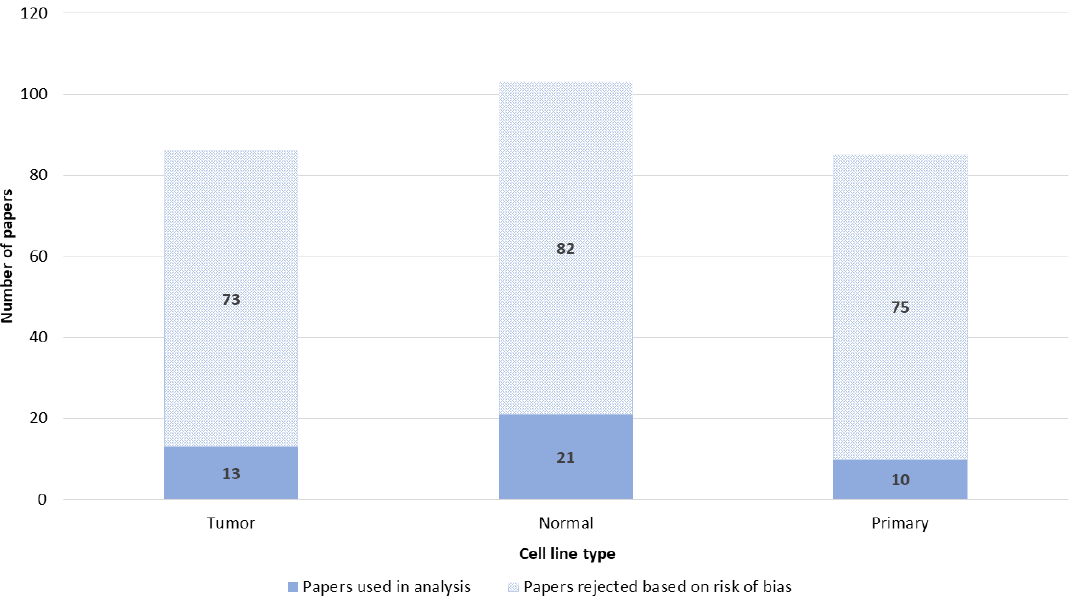
Figure 11. Type of cell line.